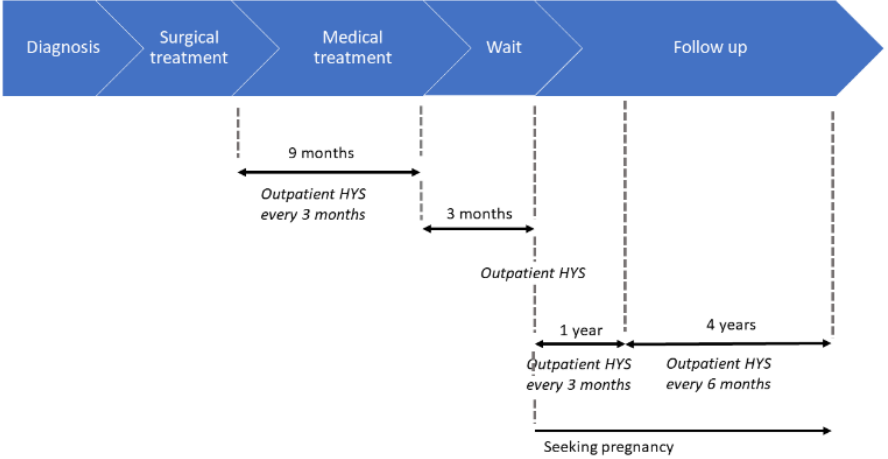
Figure 3. Timeline of the steps of the treatment and subsequent follow-up.